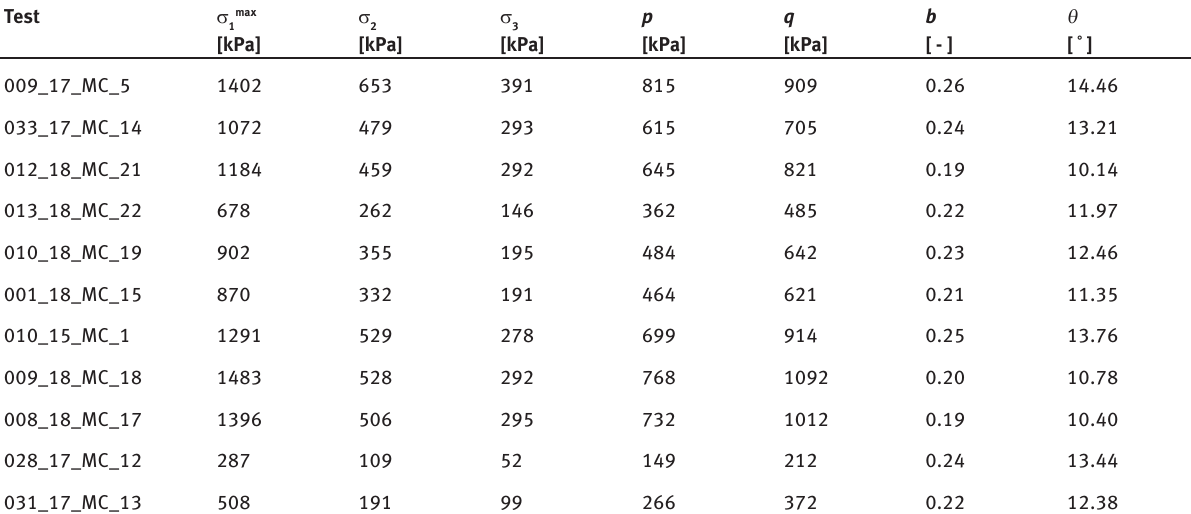
Figure 10: Results of the experimental tests listed in Table 1: principal stress in the direction of fixed strain ( e of the axial strain s Table 3 : Characteristics of peak strength state for the tested samples.